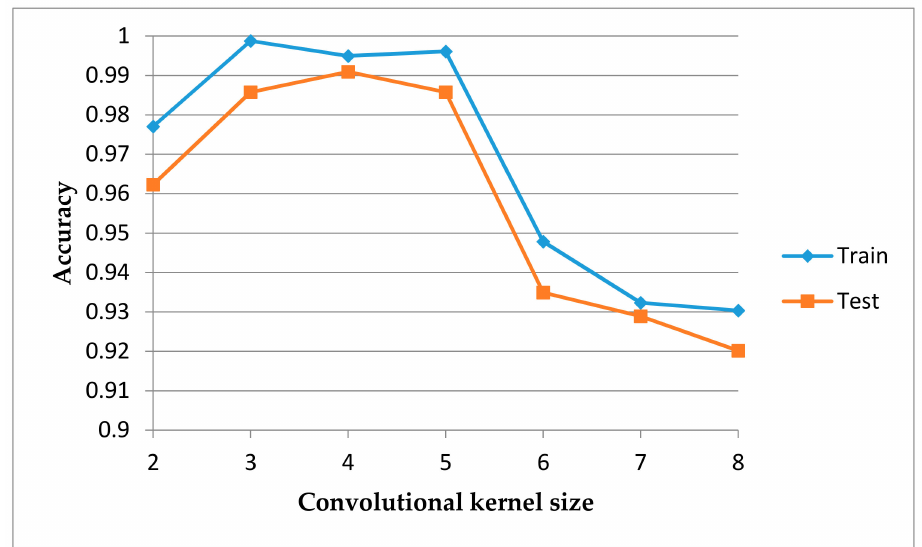
Figure 7. Effects of changing the ST-CNN model convolutional kernel